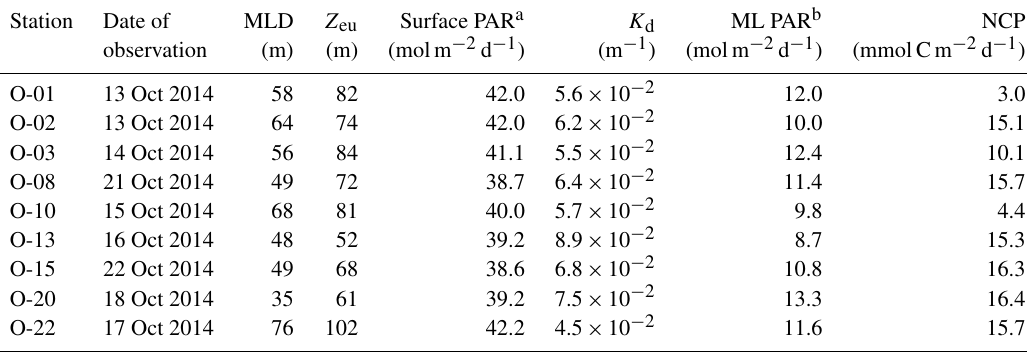
Table 4. Satellite PAR data and NCP at the selected stations in October 2014. Station Date of MLD Z eu Surface PAR a K d ML PAR b NCP observation (m) (m) (molm − 2 d − 1 )